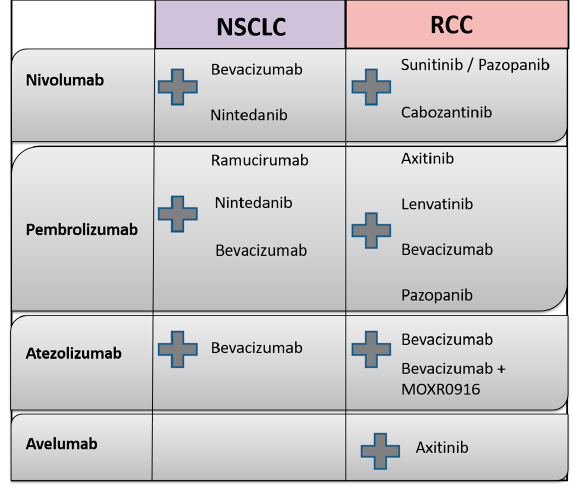
Figure 4. Overview of combination treatment of immune checkpoint inhibitors (nivolumab, pembrolizumab, avelumab and atezolizumab) with antiangiogenic agents currently investigated in clinical studies in both NSCLC and RCC (the combination treatment is represented by the grey plus sign).